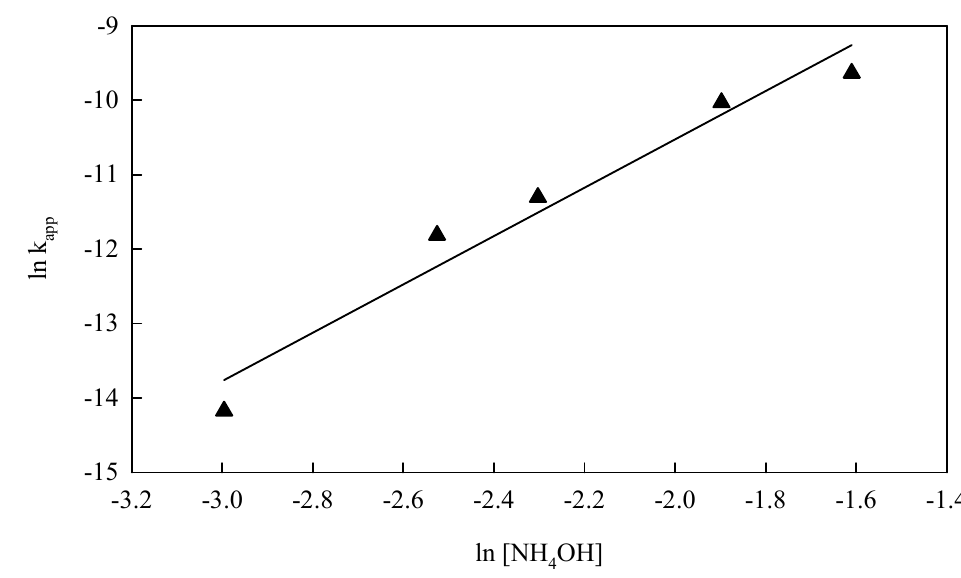
Figure 14. Reaction order calculated with regard to the concentration of NH 4 OH.